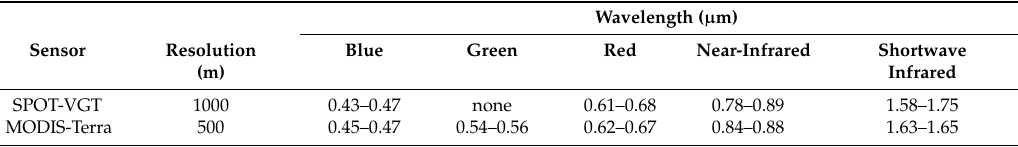
Table 3. Remote sensing sensor description.